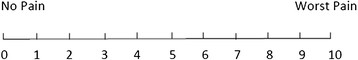
Numerical rating scale (NRS).